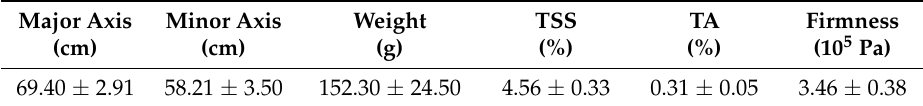
Table 1. Initial qualities of tomato